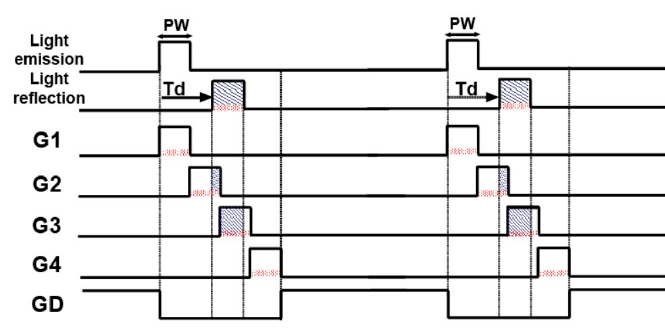
Figure 3. Timing diagram for the 4-tap lock-in pixel.